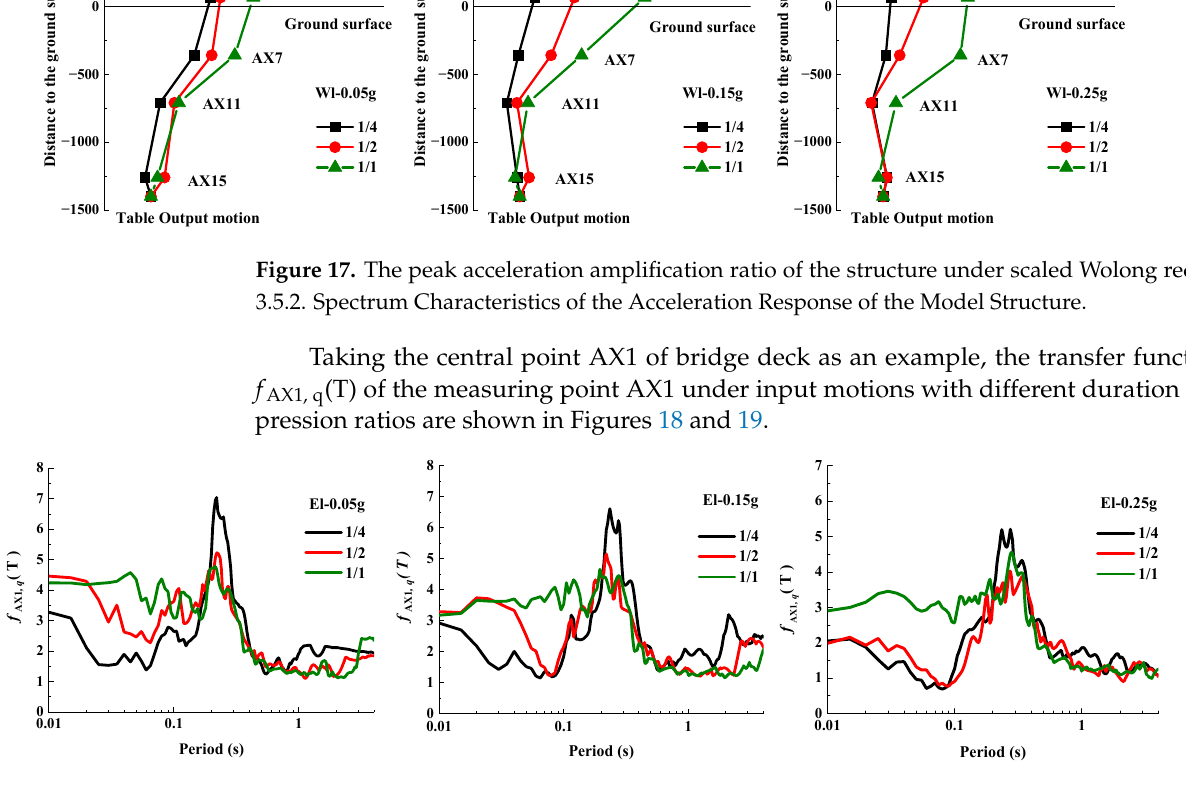
Figure 18. Transfer functions of measuring point AX1 under scaled El Centro records.